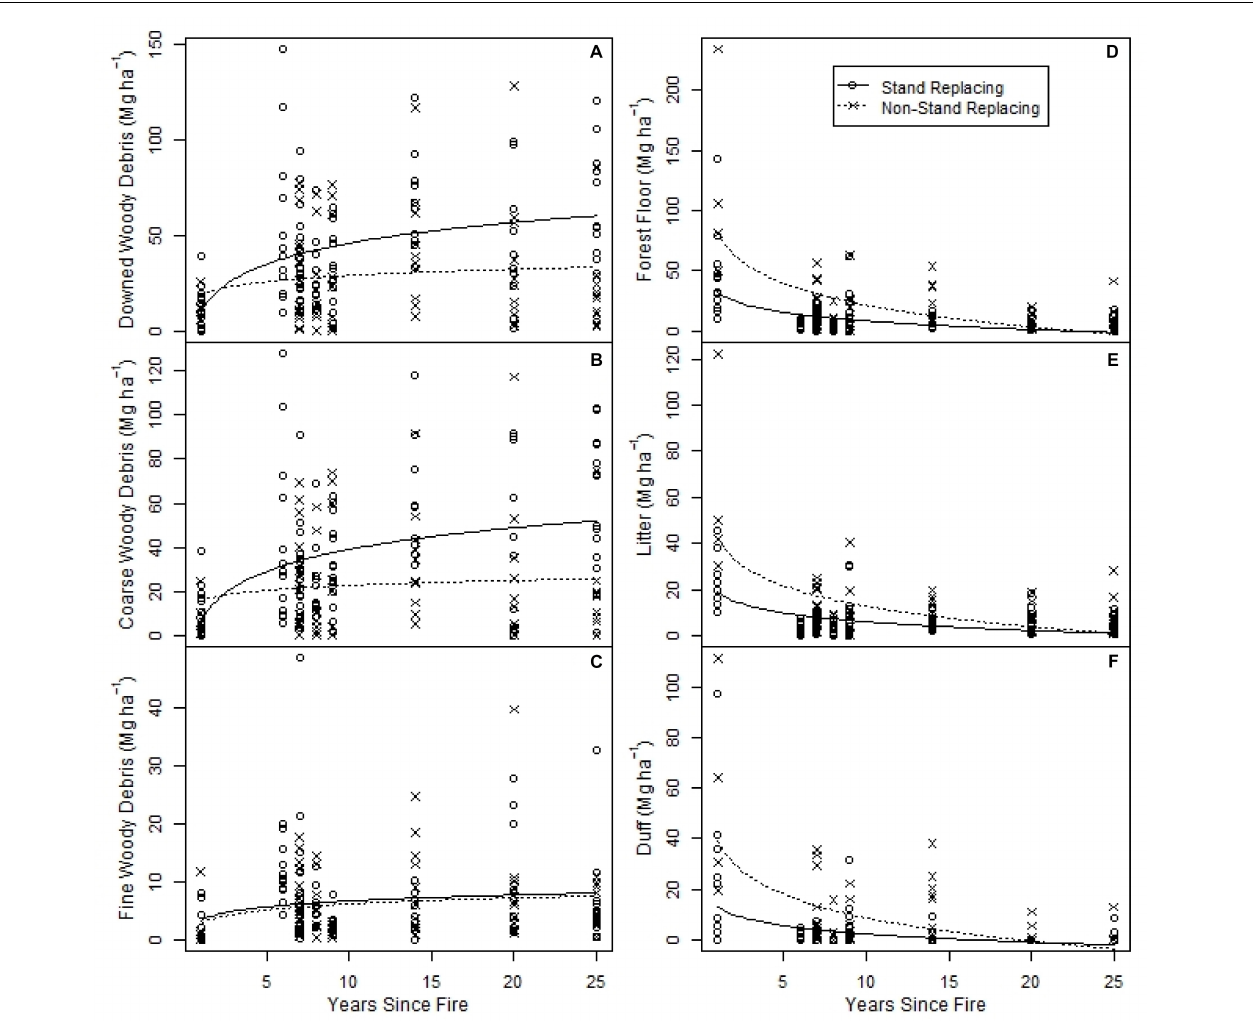
FIGURE 3 | Effect of years since fire on surface and ground fuel biomass densities: (A) Total downed woody debris. (B) Coarse woody debris. (C) Total fine woody debris. (D) Forest floor. (E) Litter. (F) Duff. Open circles indicate individual stand replacing sites and “x”s indicate non-stand replacing fire and Lines indicate natural logarithm fits for each class. Years since fire was a significantly positive predictor of downed woody debris fuels (A–C) and a significantly negative predictor for forest floor fuels ( D–F ; Table 3